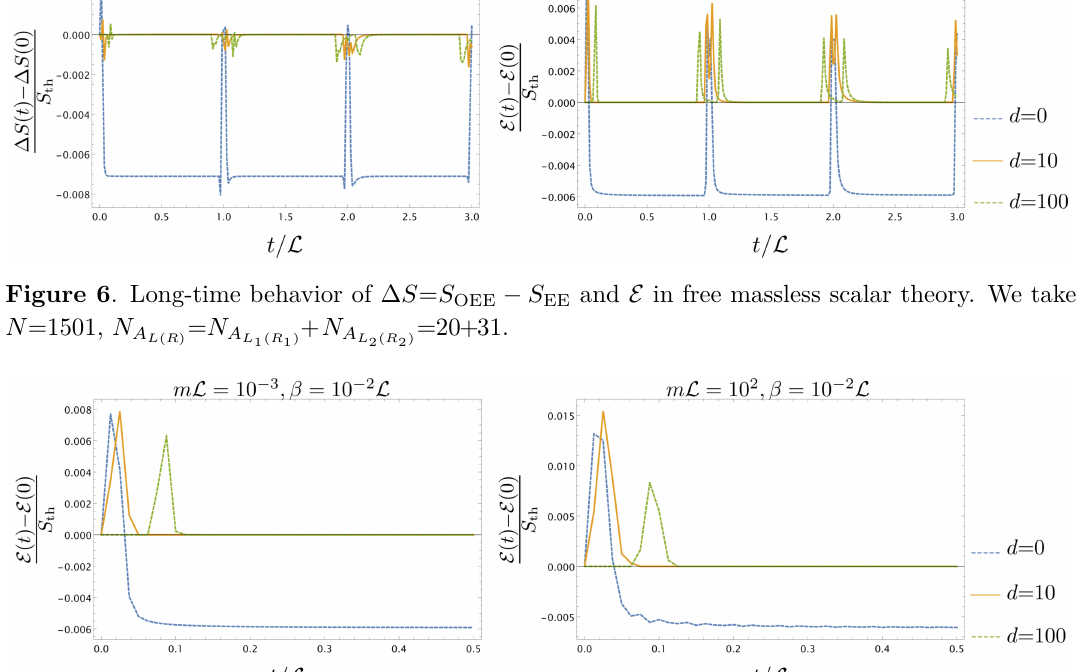
Figure 7 . Early time behavior of E in free scalar theory. We take N =1501 , N A =20+31 N A L 2( R 2)